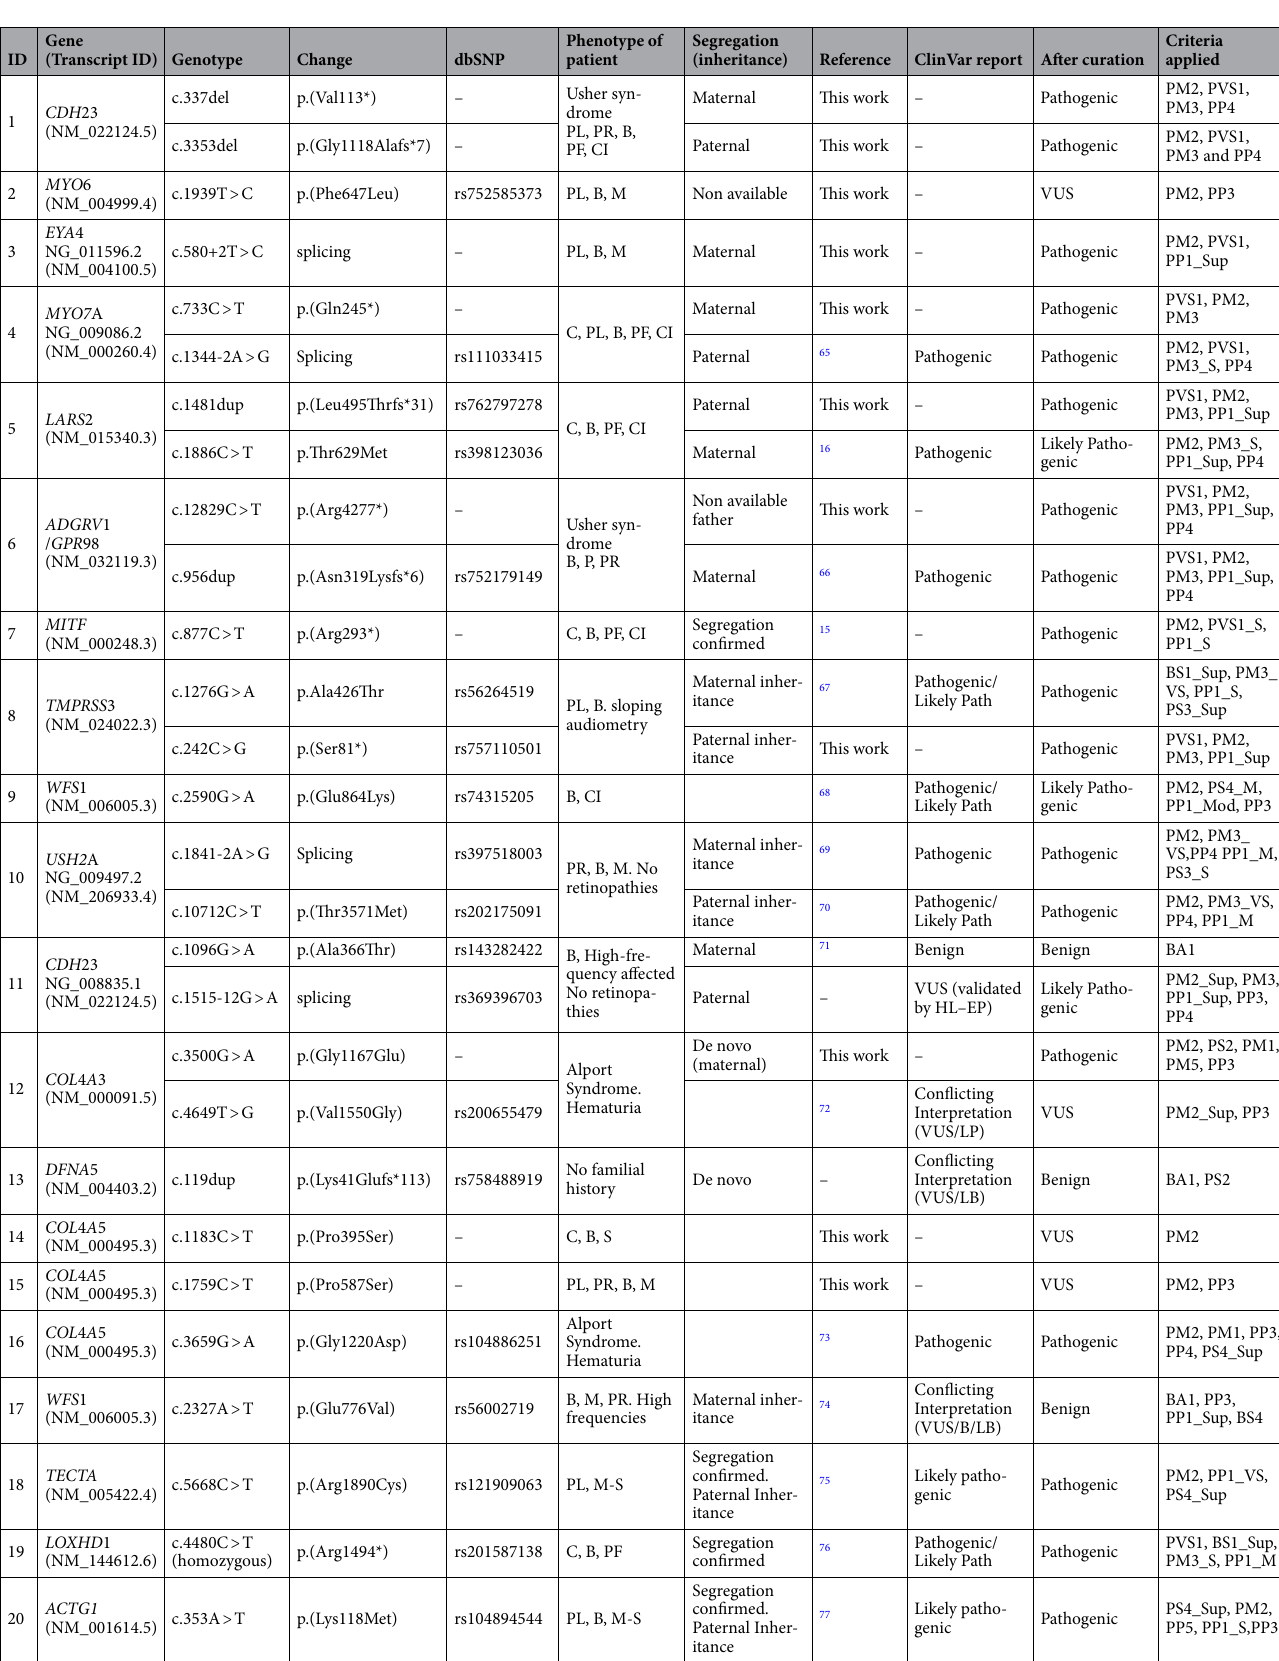
Table.2. Relevant Variants identified by WES. All variants were curated following the Hearing Loss Expert Panel recommendations. The phenotype of the patients is indicated as follows: C congenital, PL postlingual, PR progressive, B bilateral, M moderate, PF profound, S severe, CI cochlear